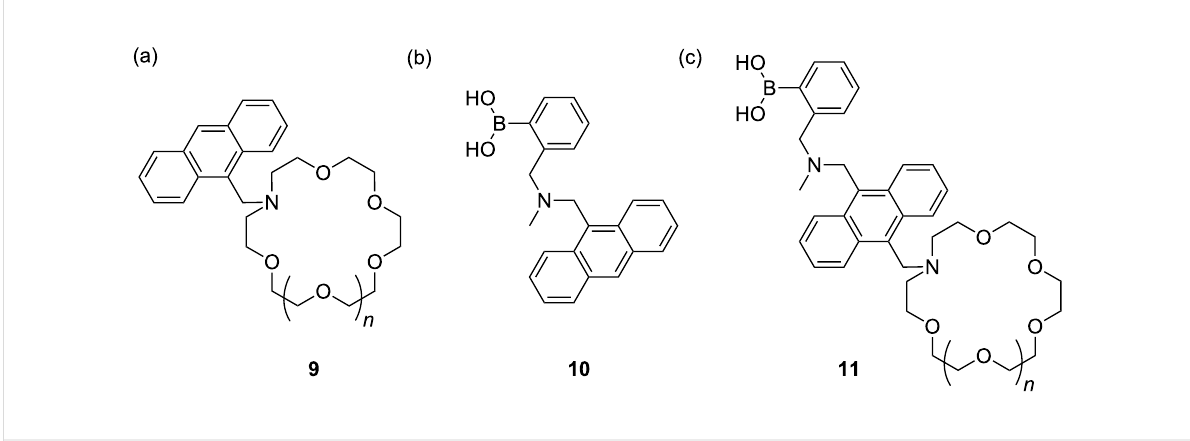
Figure 6: (a) Fluorescence photoinduced electron transfer (PET) cation sensors developed by A. P. De Silva. (b) Fluorescence photoinduced elec- tron transfer (PET) saccharide sensor. (c) Fluorescence AND logic sensors for D-glucosamine